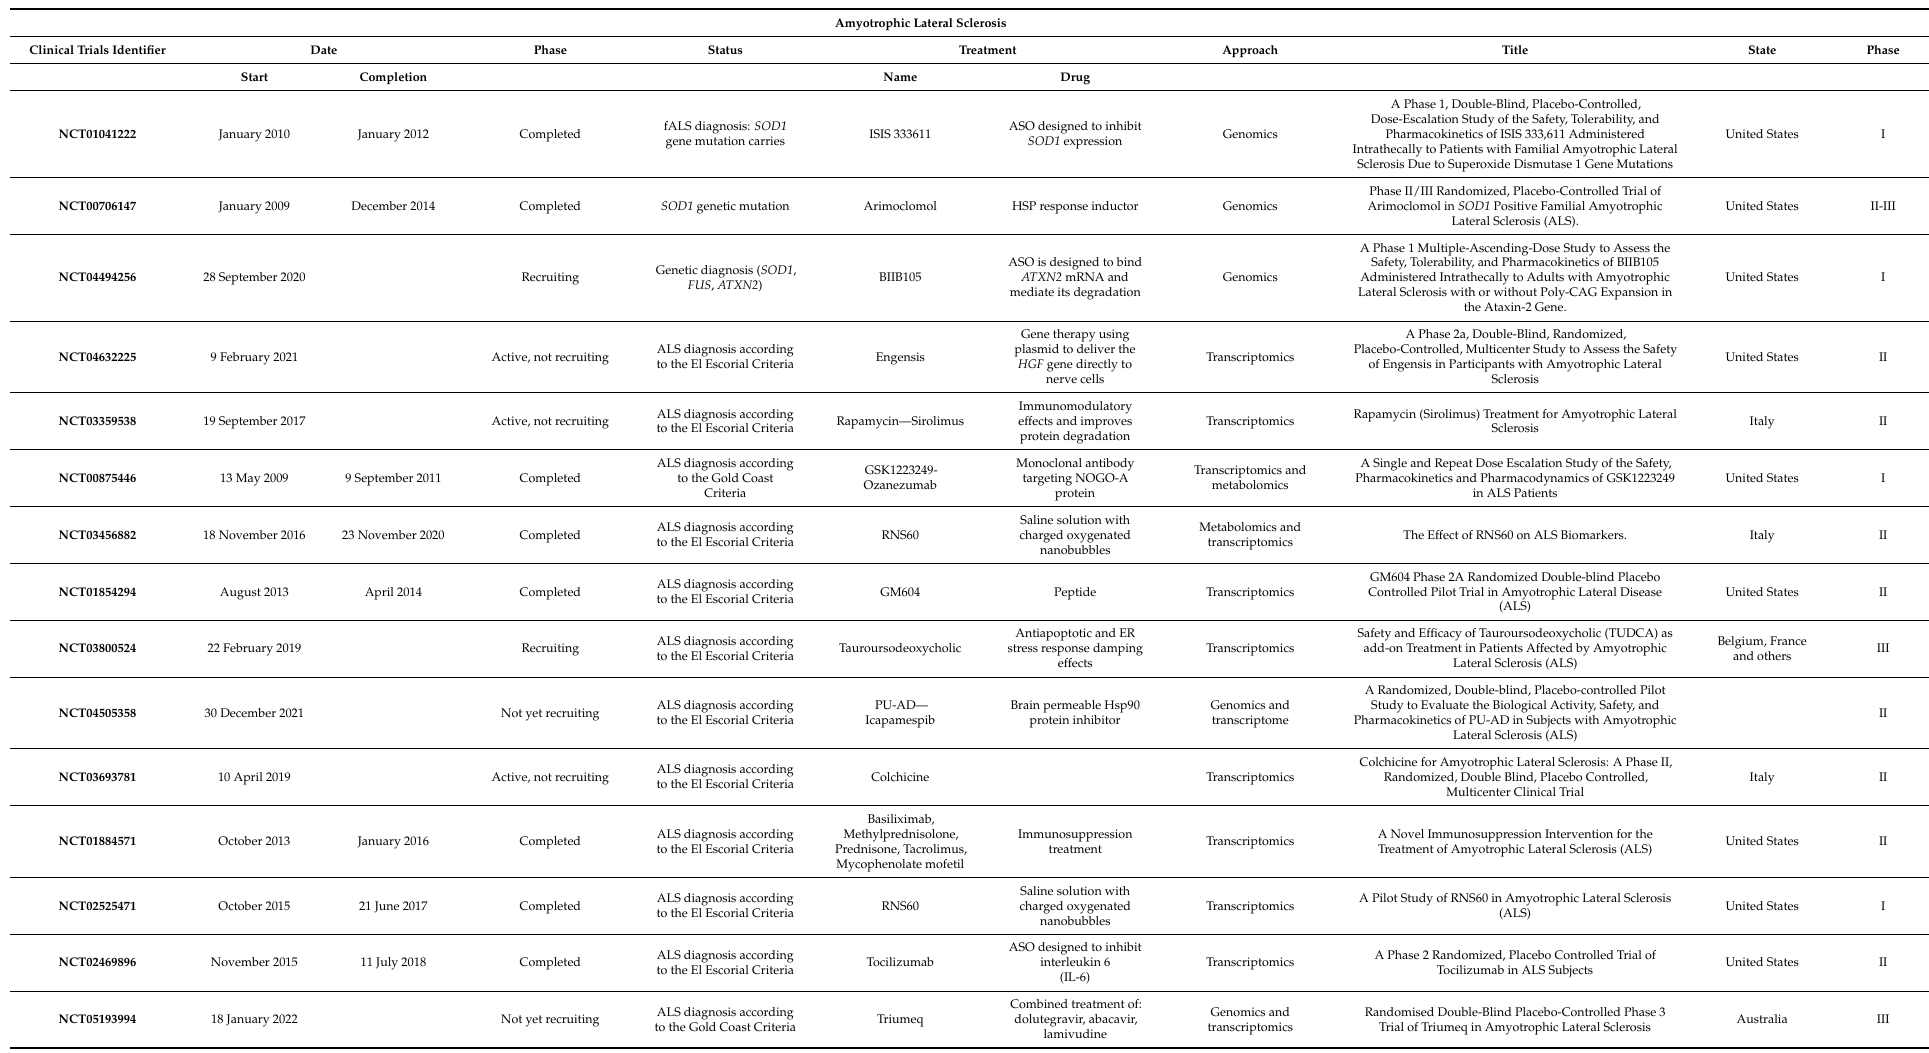
Table 1. List of clinical trials carried out on ALS using different omics